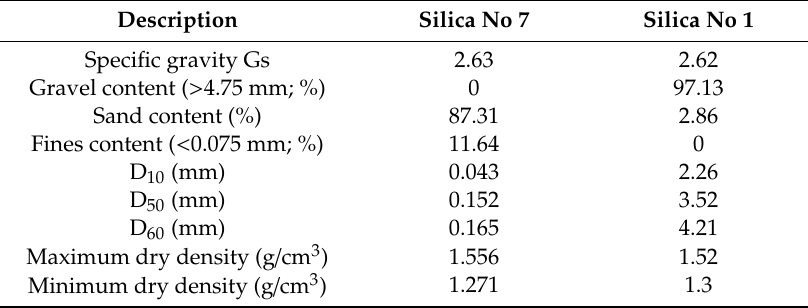
Figure 2. Grain size distribution of S1 and S7 in physical model experiments. Table 1. Basic properties of sand materials.